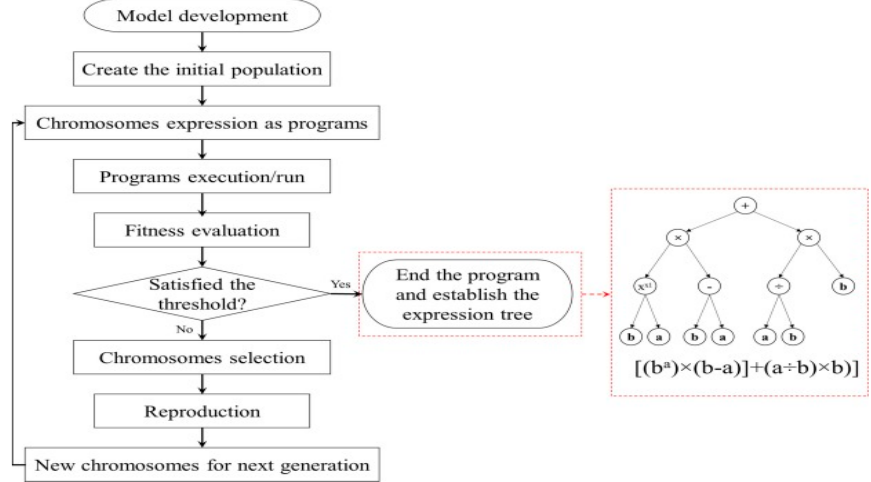
Figure 4. The modeling flowchart of GEP model